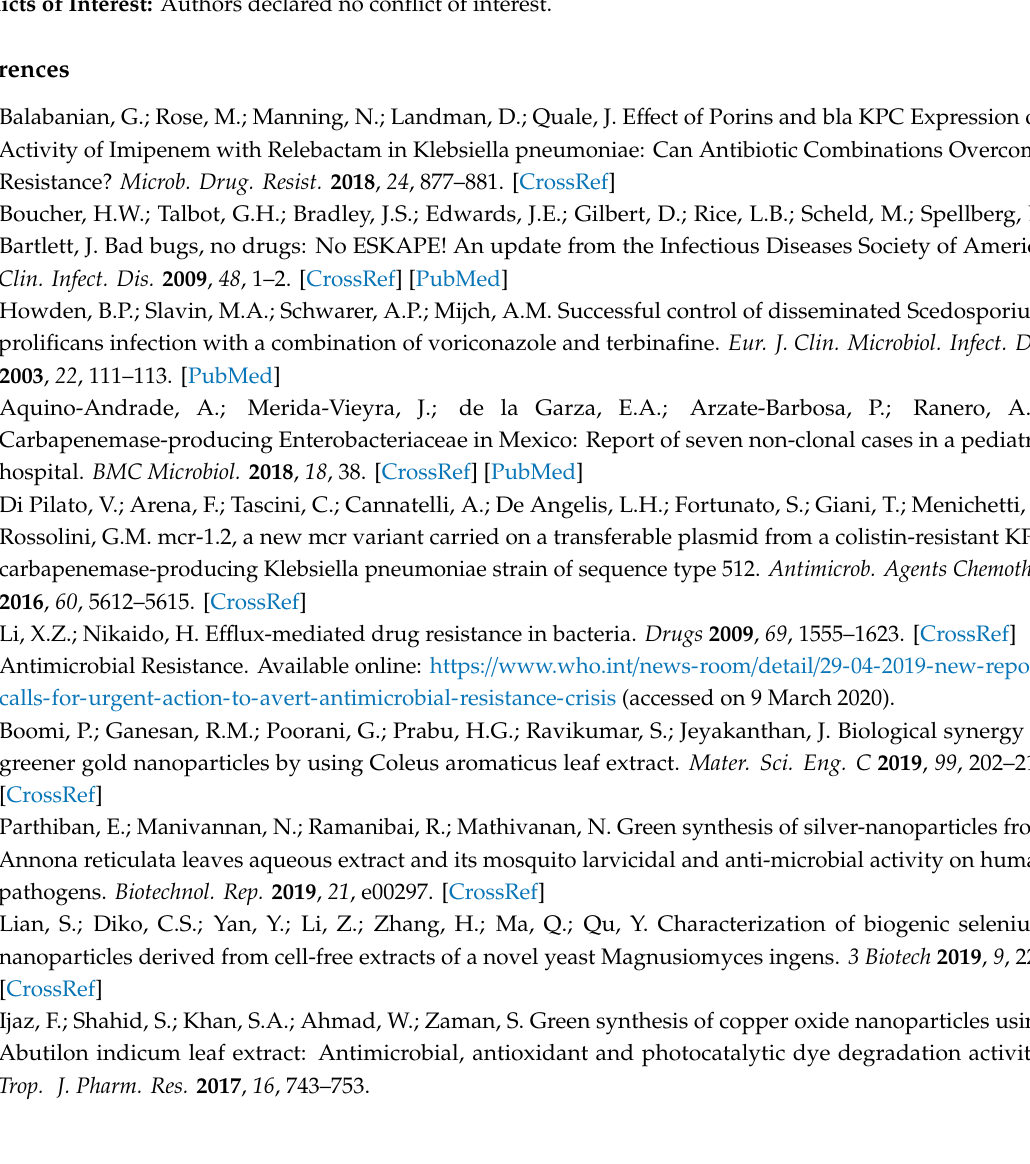
Figure S1: The particle size distribution histogram of green synthesized (a) CI-Au and (b) CI-Ag NPs from TEM, Figure S2: Hemolysis activity of di ff erent concentrations of green synthesized CI-Au, and CI-Ag NPs in comparison to C. inerme leaves extract, Au NPs, and Ag